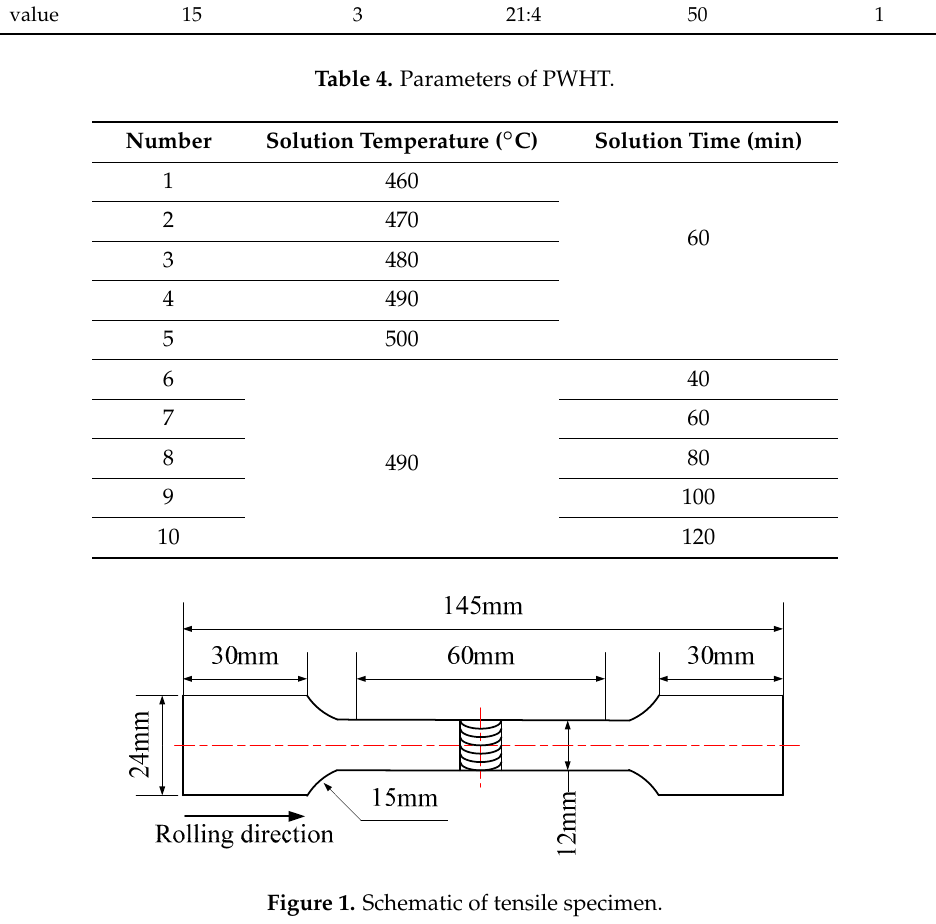
Table 3. Welding parameters of PVPPA